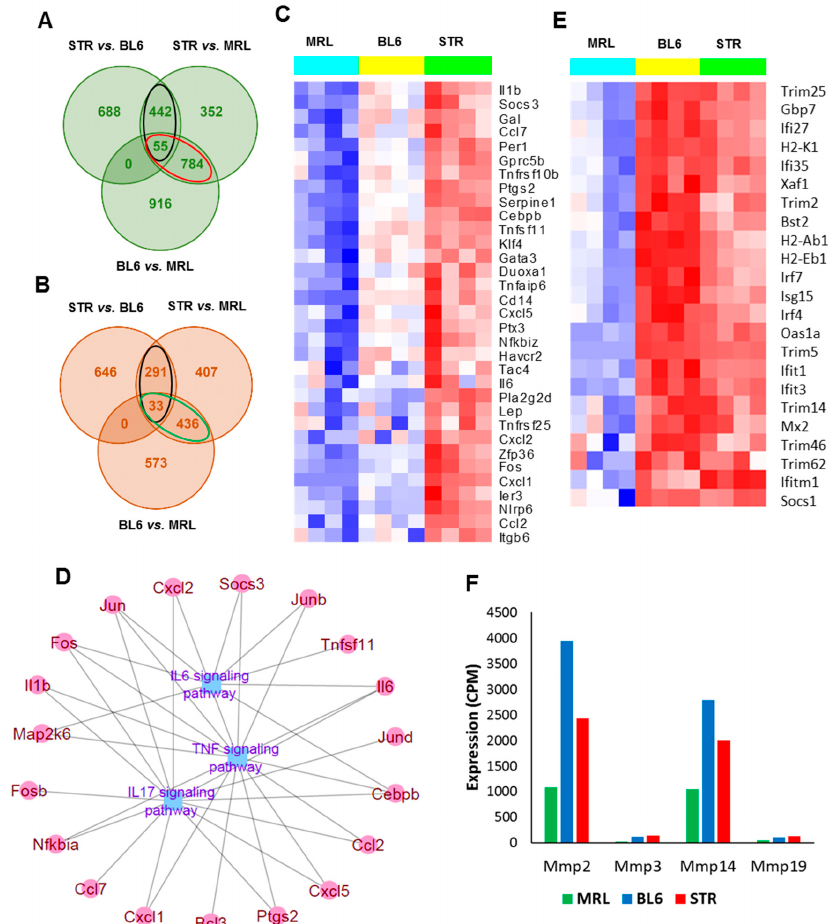
Figure 2. Genes associated with osteoarthritis susceptibility. ( A ) Overlap between genes upregulated in STR/ort (STR) compared to C57BL/6J (BL6) and MRL/MpJ (MRL) mice and in BL6 compared to MRL at 0 ‐ day. Genes upregulated in STR compared to both BL6 and MRL are shown in black ovals and genes downregulated in MRL (upregulated in both STR and BL6 compared to MRL) are shown in red ovals. ( B ) Overlap between genes downregulated STR compared to BL6 and MRL and in BL6 compared to MRL at 0 ‐ day. Genes downregulated in STR compared to both BL6 and MRL are shown in black ovals and genes upregulated in MRL (downregulated in both STR and BL6 compared to MRL) are shown in green ovals. ( C ) Inflammatory ‐ response ‐ related genes highly expressed in STR compared to BL6 and MRL at 0 ‐ day. ( D ) TNF, IL17, and IL6 signaling pathway ‐ associated genes with high expression in STR compared to both BL6 and MRL. ( E ) Interferon signaling pathway ‐ associated genes with low expression in MRL compared to both STR and BL6. ( F ) Matrix metalloproteinases (MMPs) with low expression in MRL compared to both STR and BL6.